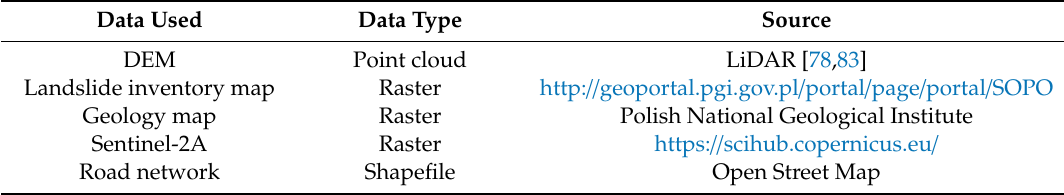
Table 1. Data used, their types, and their